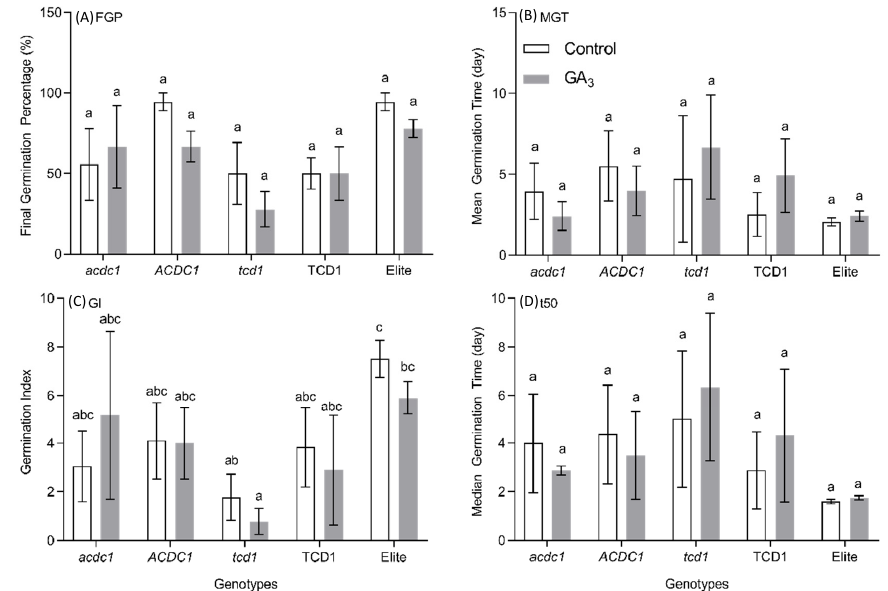
Figure 3. The effect of gibberellic acid (GA 3 ) on germination of five sorghum genotypes: elite (parent line from which mutants are derived), totally cyanide deficient class 1 ( tcd1 ) mutant, sibling line of tcd1 mutant without the target mutation (TCD1), adult cyanide deficient 1 ( acdc1 ) mutant and sibling line of acdc1 mutant without the target mutation (ACDC1); ( A ): Final Germination Percentage (FGP); ( B ): Mean Germination Time in days (MGT); ( C ): Germination Index (GI); ( D ): Median Germination Time in days (t50). Bars with the same letter are not significantly different from each other ( p > 0.05; Tukey’s HSD pairwise test).